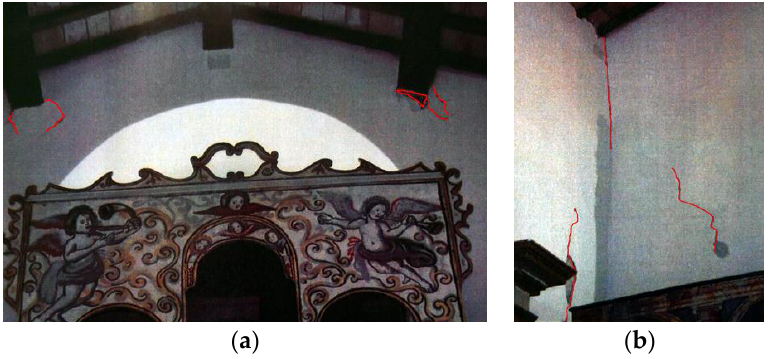
Figure 19. Post-2016 earthquake damage of the inside view of the west wall of the church. ( a ) Cracks at the intersection between the beams of the roof and the facade [47]; ( b ) vertical crack between the façade and the lateral wall where there are also diagonal cracks [47].